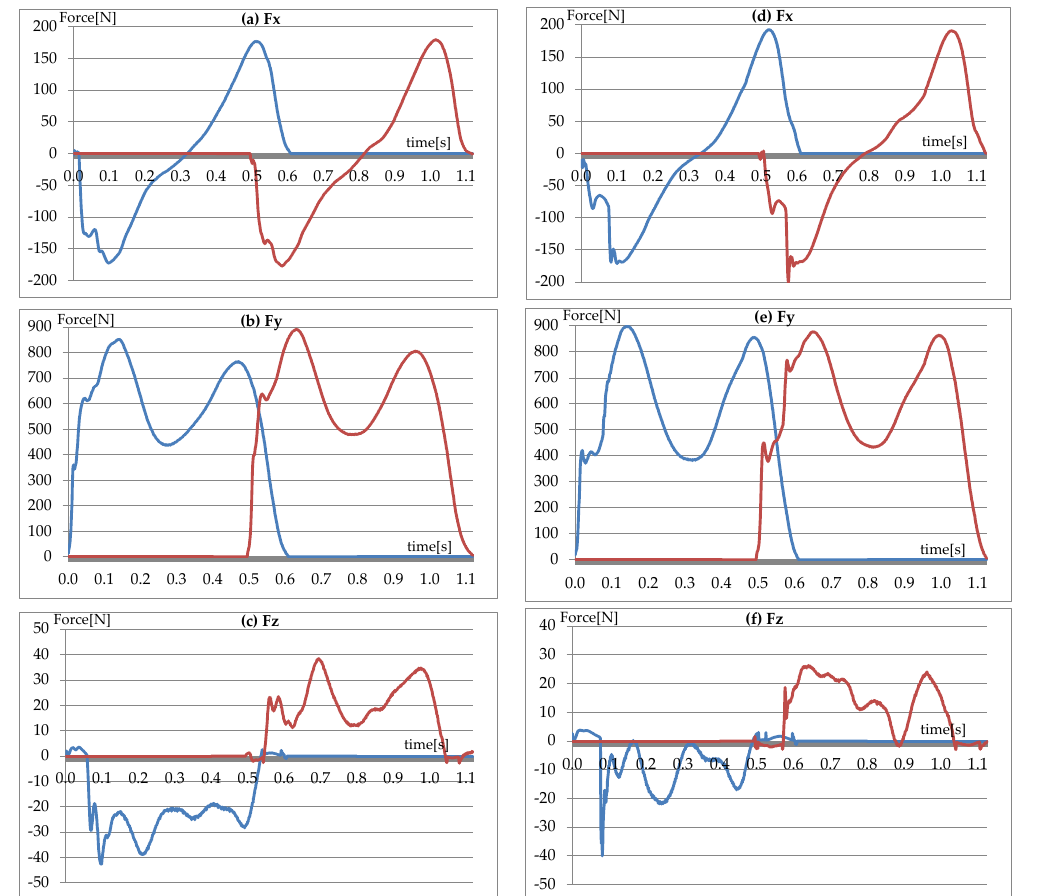
Figure 1. Components of GRF in: ( a , d ) anterior/posterior; ( b , e ) vertical; ( c , f ) medial/lateral direction of the left lower limb (blue line) and of the right one (red line) in sport shoes ( a – c ) and high heels ( d – f ). Data derived from the same subject.